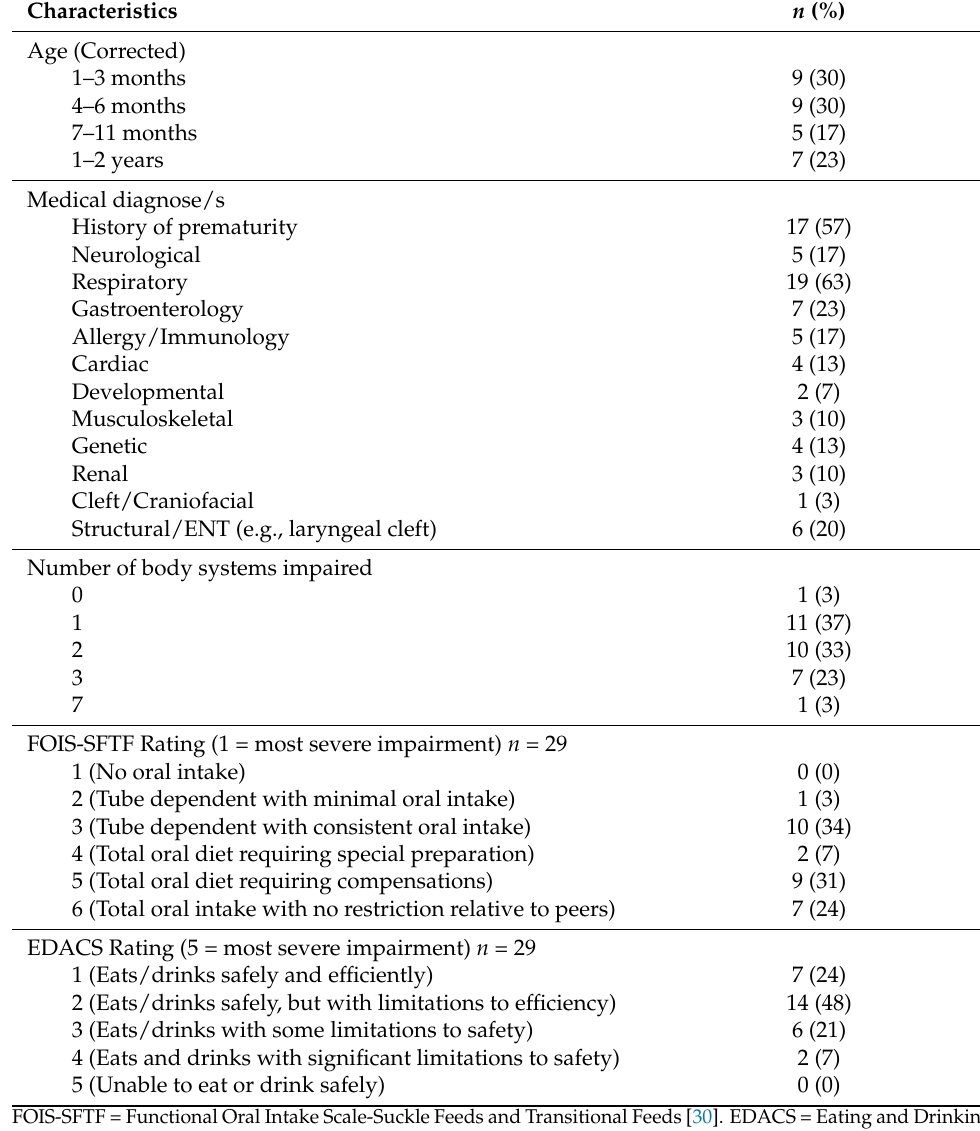
Table 1. Infant’s medical and feeding background ( n =